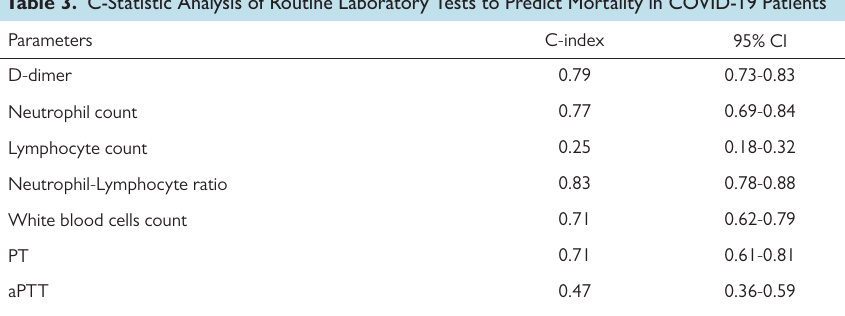
White blood cells